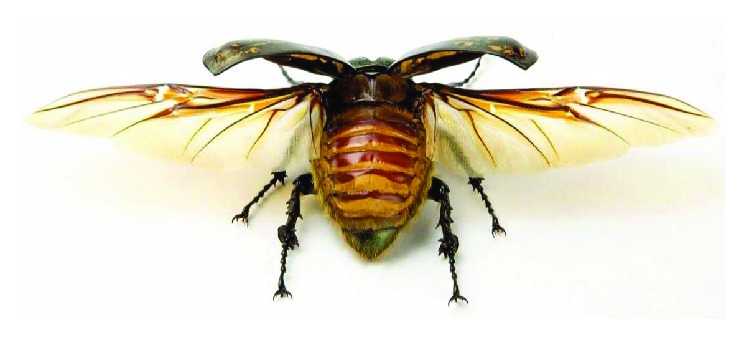
Wings of beetle.